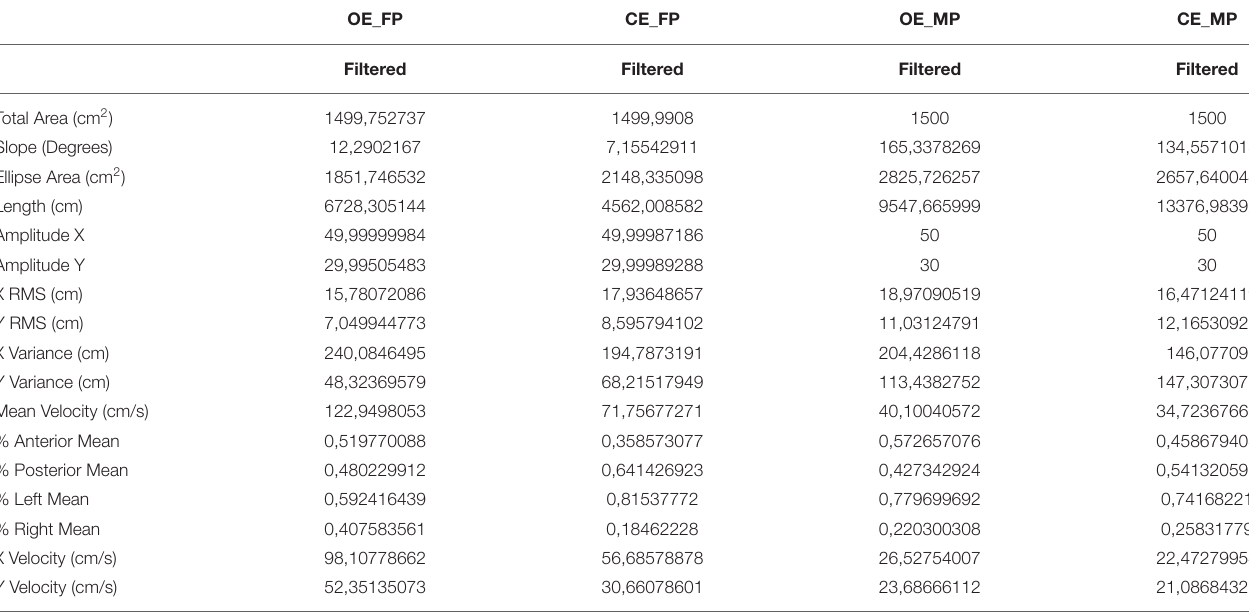
TABLE 1 | The scores of the posturography variables obtained in the evaluation of the sensory organization test in the four test conditions.